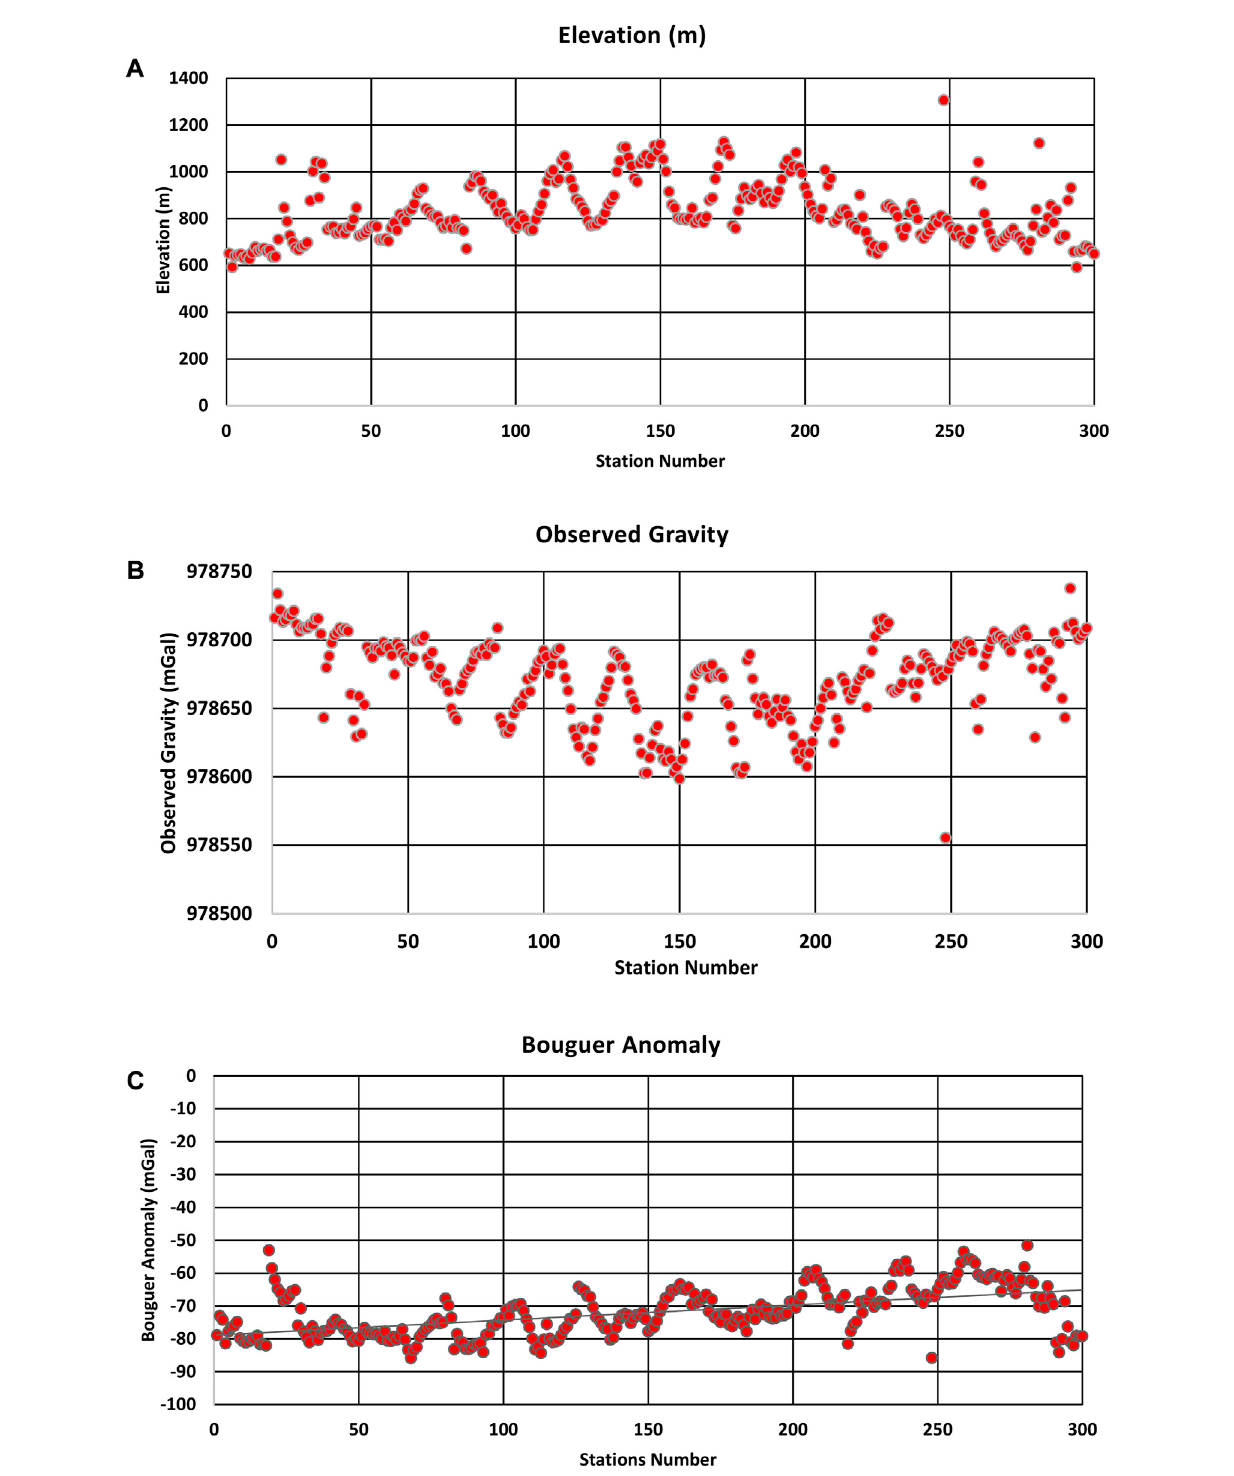
FIGURE 5 (A) Graph showing the general trend of elevation in the Rahat Volcanic Field. The elevation lies between the depth of 600 – 1100 m. (B) Graph demonstrates the overall variation of observed gravity in the Rahat Volcanic Field. The unit of observed gravity is usually in mGal. The result of observed gravity and Bouguer anomaly shown in Figure 5C demonstrates the inverse trend. (C) Graph represents the overall variation of Bouguer anomaly in the Rahat Volcanic Field. The Bouguer anomaly shows the trend that is present in the subsurface. The values of Bouguer anomalies are in the range of − 85 to − 50